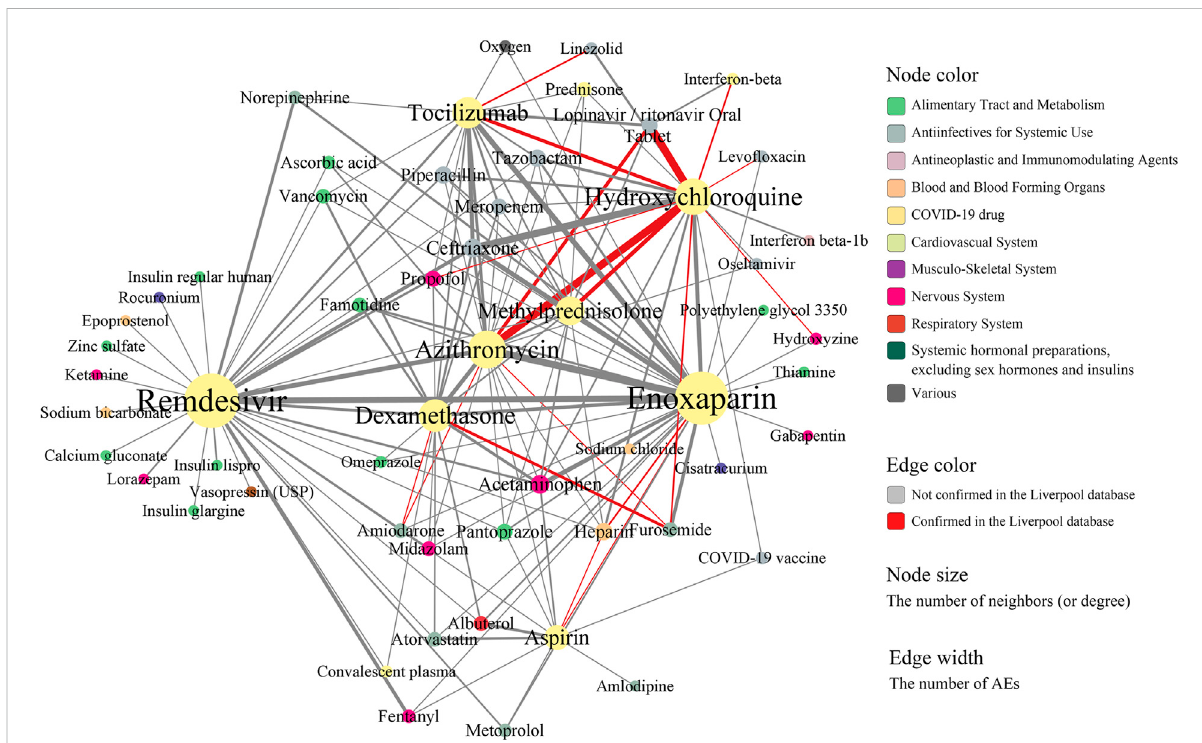
FIGURE 2 Drug-drug interaction network. The size of a node is proportional to thenumber of neighboring drugs, while the color corresponds to the ATC 1stlevel.ThewidthofanedgeisproportionaltothenumberofuniqueAEs,whileitscolorindicateswhetherornotaninteractionwasdocumentedin the Liverpool database.